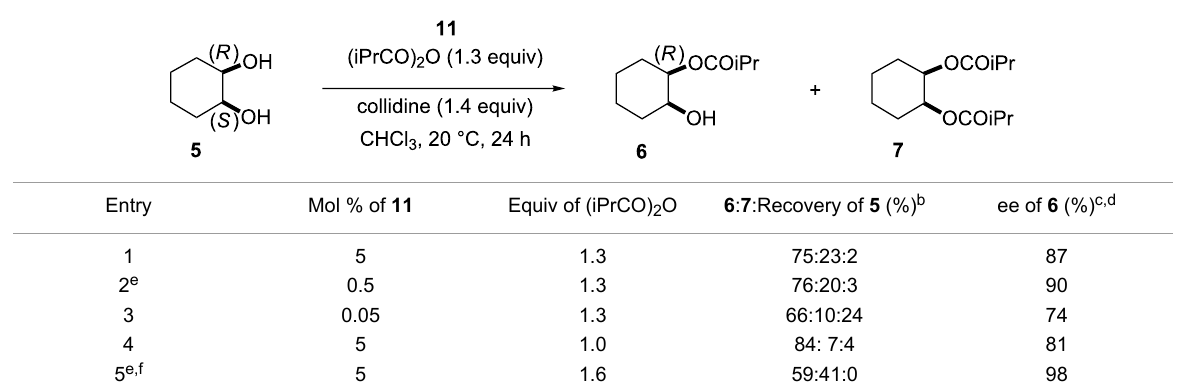
Table 3: Optimization of the asymmetric desymmetrization of 5 with catalyst 11 .